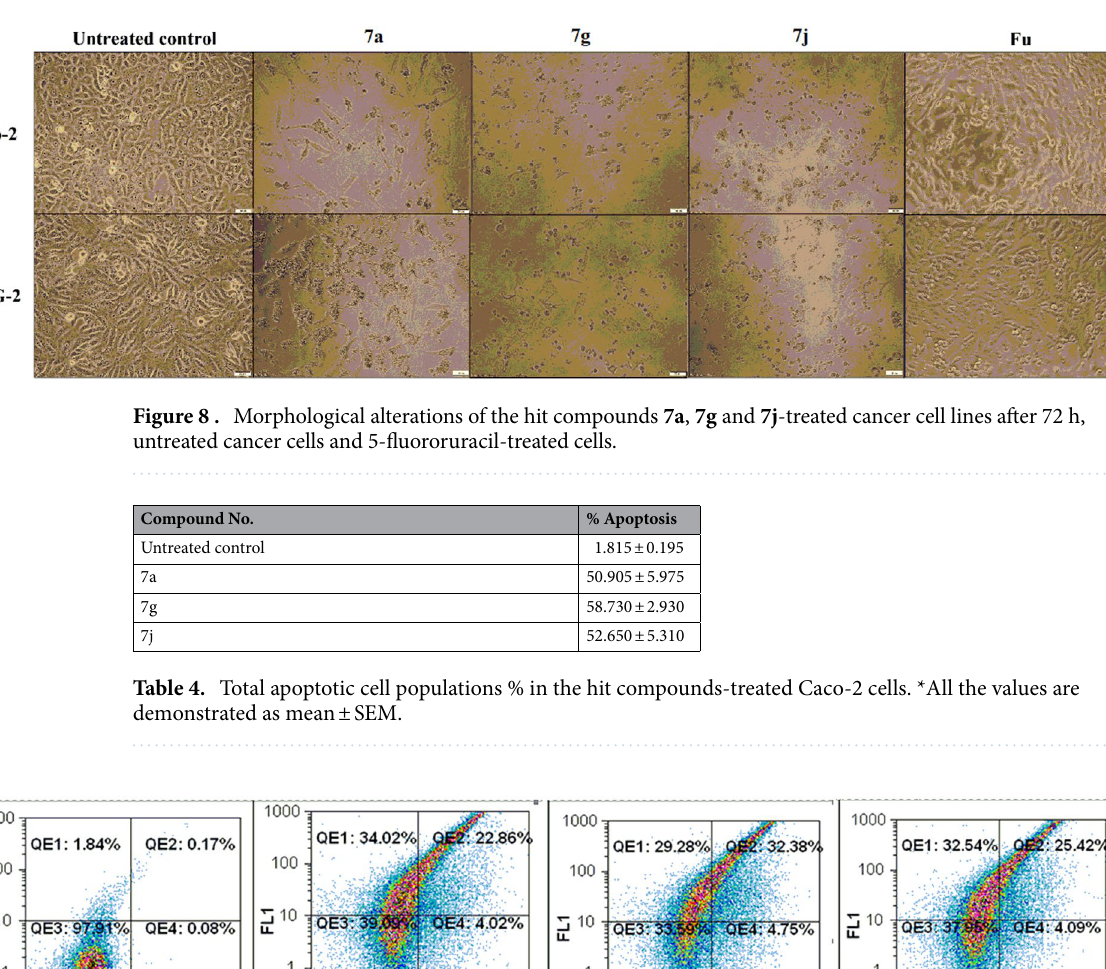
Figure 9. Flow cytometric analysis of apoptosis induction in the most active compounds-treated Caco-2 compared to untreated control cells, after staining with annexin V/propidium iodide.